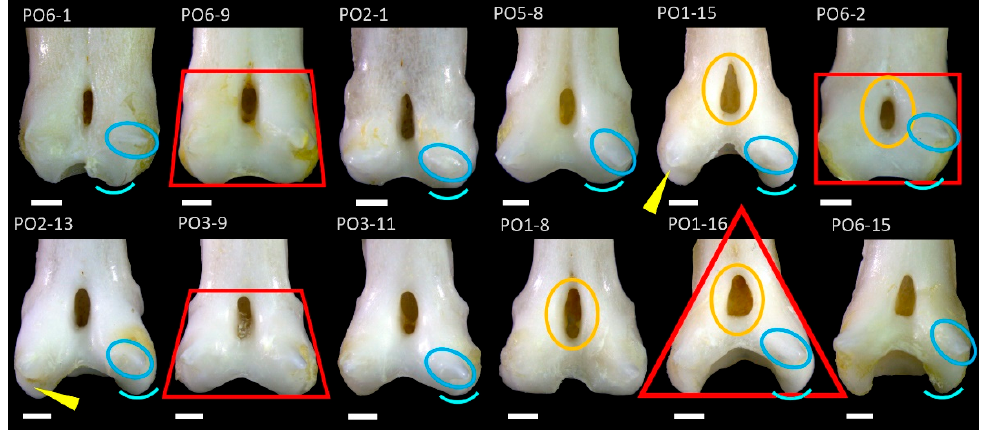
Figure 3. Microscopic images of the posterior view of different pinnules of different specimens of P. bichir . Each number corresponds to the respective position on the dorsal fin. Scale bars = 1 mm. The red polygons evidence the various shapes of the head in posterior view. The blue lines underline the various relative orientations of the posterior process (circle), and its position is more or less lateral compared to the basal process (cup). The yellow arrows point at shallow depressions between the basal and posterior processes. The orange oval underlines the foramen with different shapes. Scale = 1